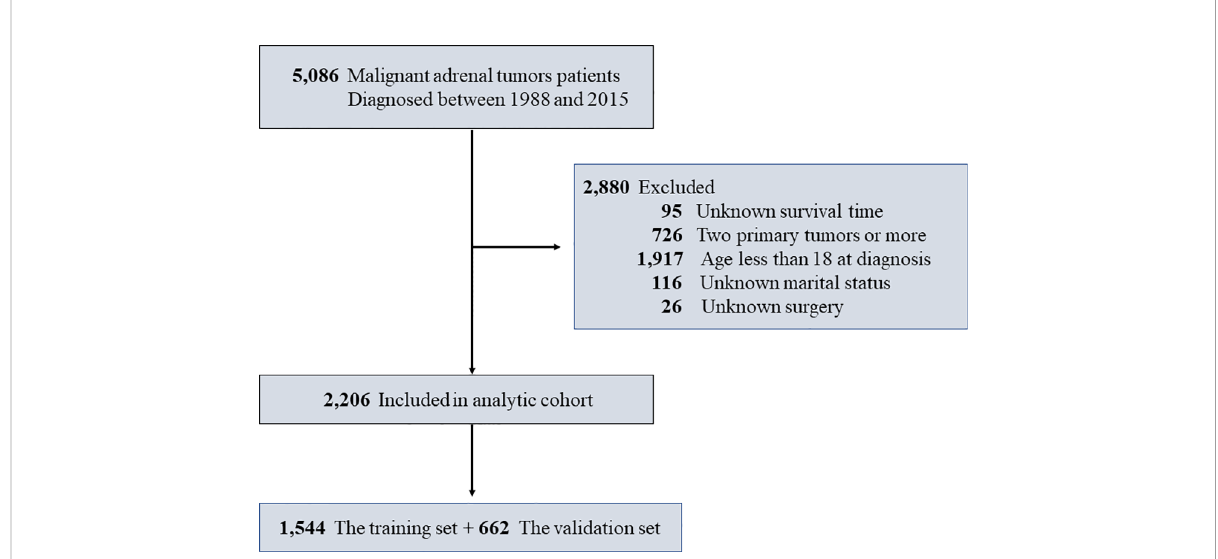
FIGURE 1 Study design fl owchart of speci fi c patient screening